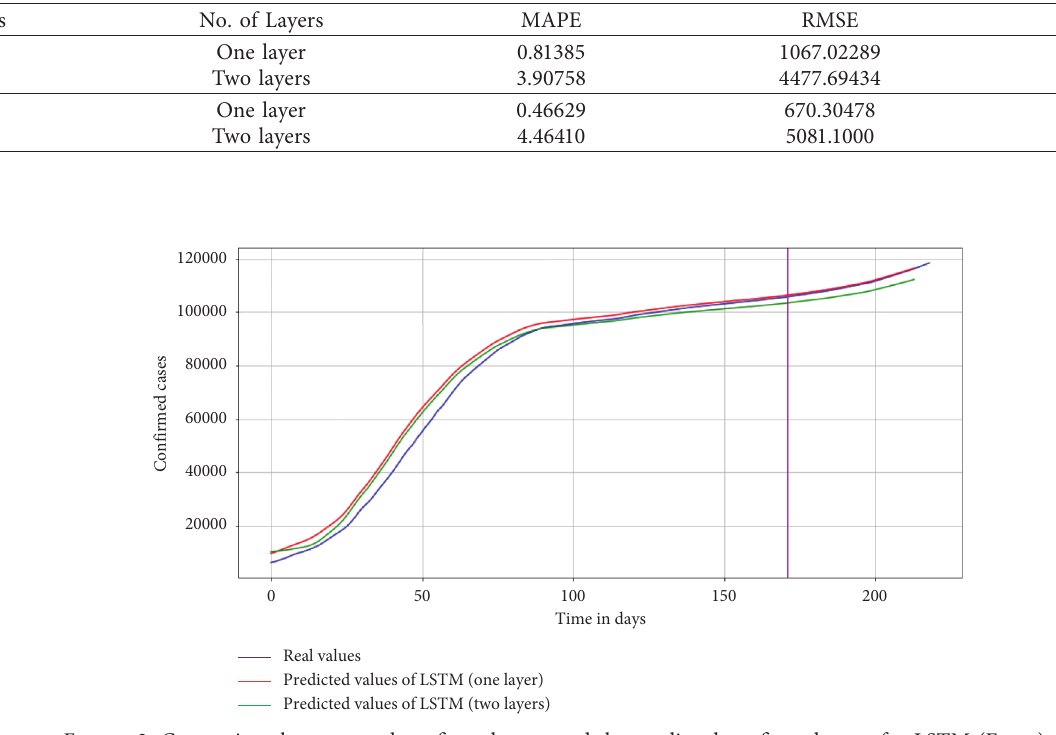
Figure 2: Comparison between real confirmed cases and the predicted confirmed cases for LSTM (Egypt).